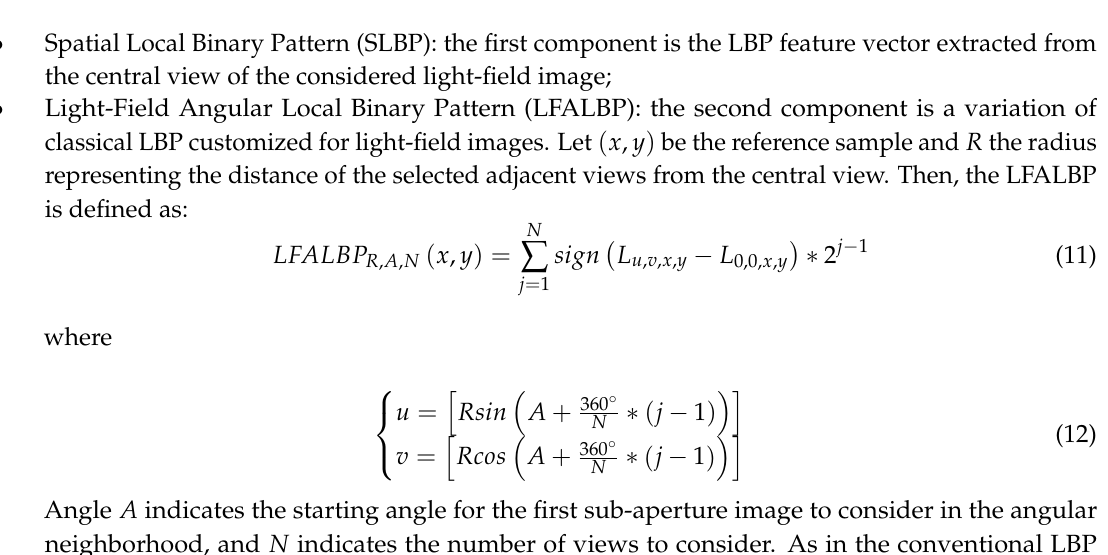
Figure 11. Visual representation of ( a ) Spatial Local Binary Pattern (SLBP) and ( b ) Light-Field Angular Local Binary Pattern (LFALBP) used in